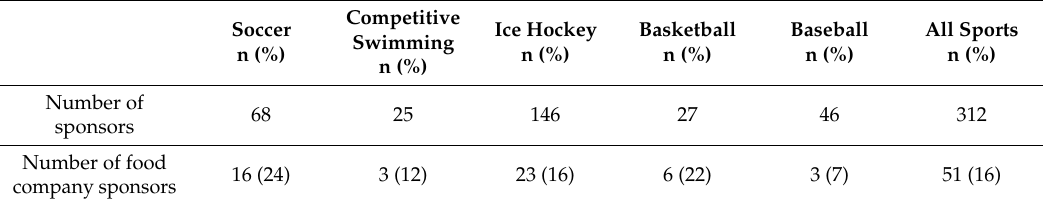
Table 2. Total number of sponsors and percentage of food company sponsors, overall and by sport, among children’s sports clubs in Ottawa